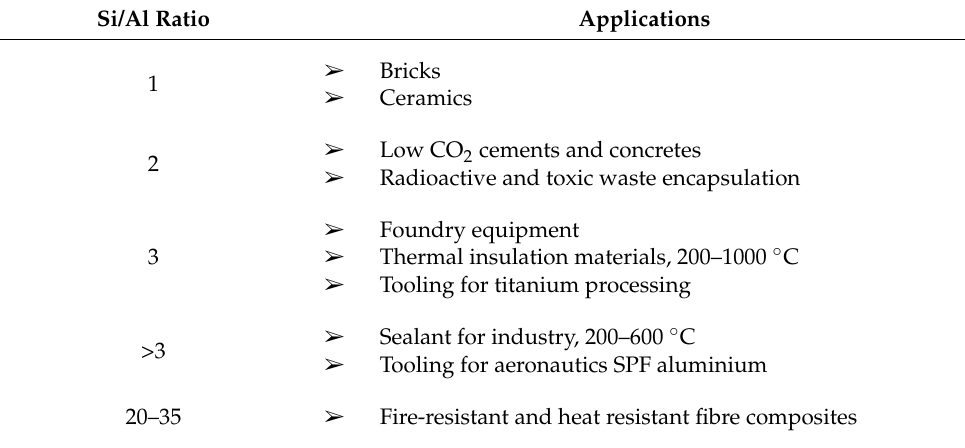
Table 1. Geopolymer materials applications